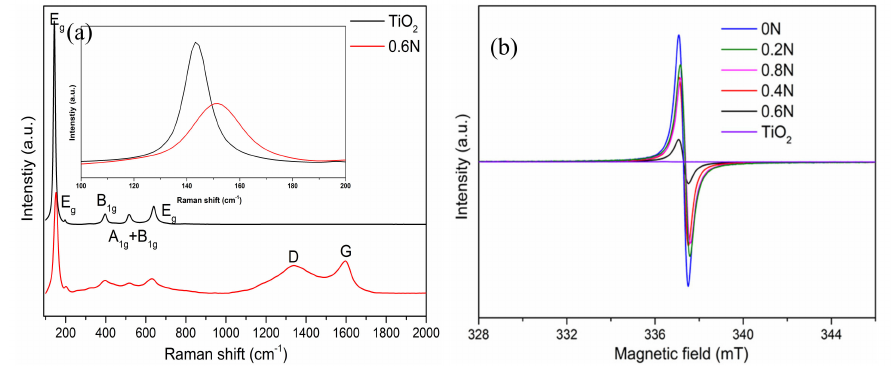
Figure 3. ( a ) Raman spectra of pure TiO 2 and 0.6N, and amplification of the evident E g peak; ( b ) EPR signals of as-prepared TiO 2 samples.